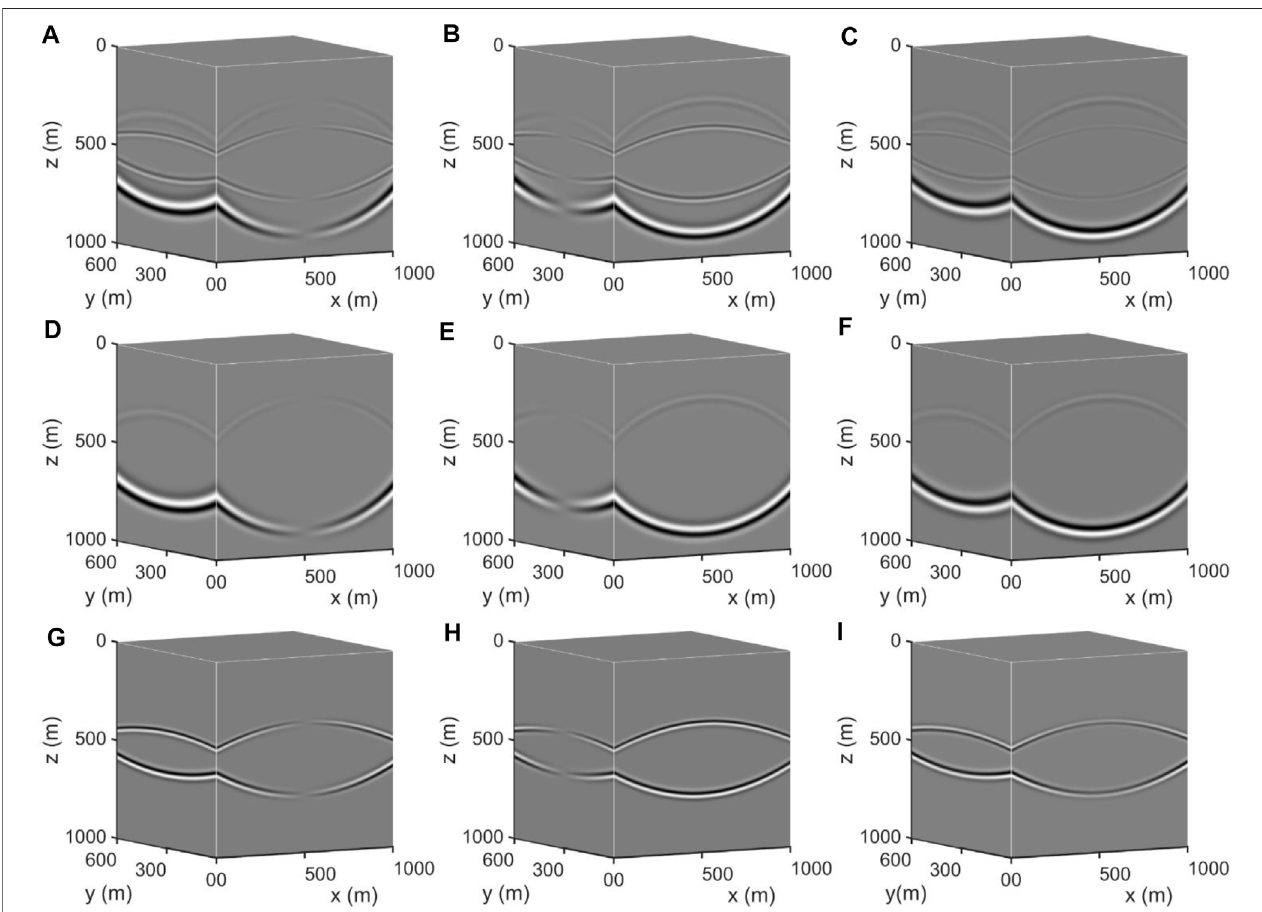
FIGURE 1 | Three-component snapshots of particle velocity at 0.4 s computed based on Eq. 1 . (A – C) The joint velocity components of P- and S-waves in x , y , z directions, (D – F) TheP-wavecomponents in x , y , z directions computed by applying Eq.1 , (G – I) The S-wave componentsin x , y , z directionscomputedbyapplying Eq. 1 .